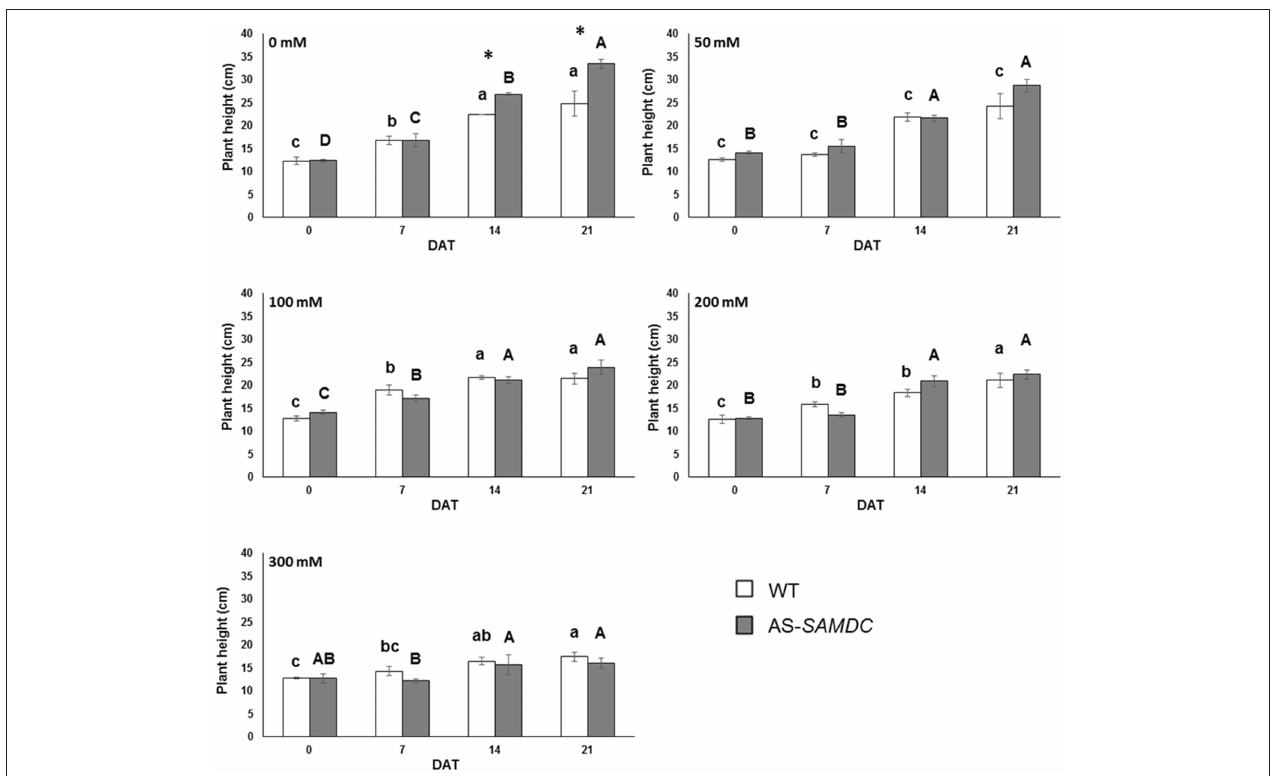
FIGURE 3 | Plant height of WT and AS- SAMDC plants under control and NaCl treatment. Plant height in cm at different NaCl concentrations (0, 50, 100, 200, 300mM), 0, 7, 14, and 21 DAT. Data are means ± SE. Different letters (lower case for WT, upper case for AS- SAMDC ) indicate significant differences over time within the same genotype, based on Tukey’s HSD test ( P < 0.05). Asterisks indicate significant difference of mean values of AS- SAMDC from WT (Student’s t -test; * P <